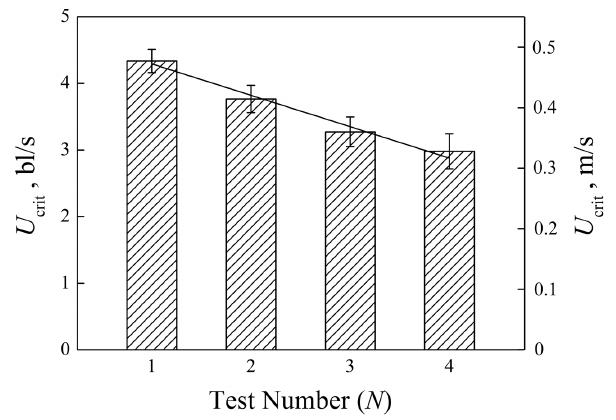
Figure 1. Variation of critical swimming speed ( U crit , mean ± S.E.) over four cycles of fatigue-recovery.